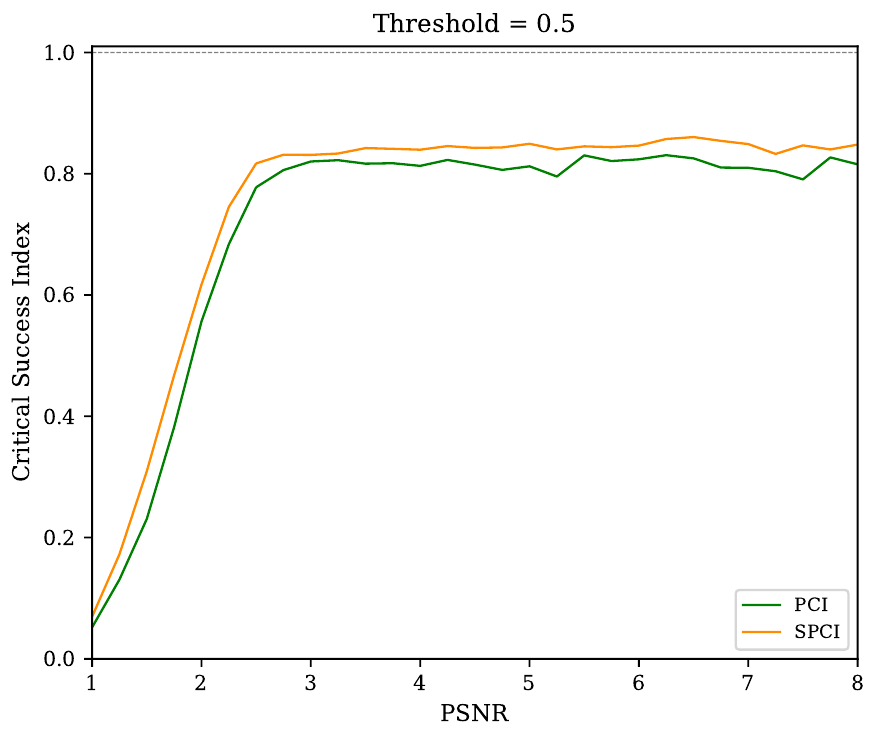
Figure 12. Critical Success Index estimation of both correlation indices (PCI and SPCI) versus PSNR. The recognition performance is shown to be similar and close to 80% in all cases, even at PSNR values as low as three and pile-up caused by the parameter β = 5, while remaining practically unchanged up to the maximum evaluated limit. A convenient threshold value (0.5) is set to reinforce the discrimination robustness under diverse noise